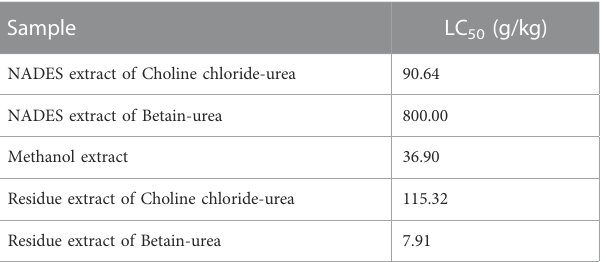
TABLE 2 Hepatotoxic pro fi ling of